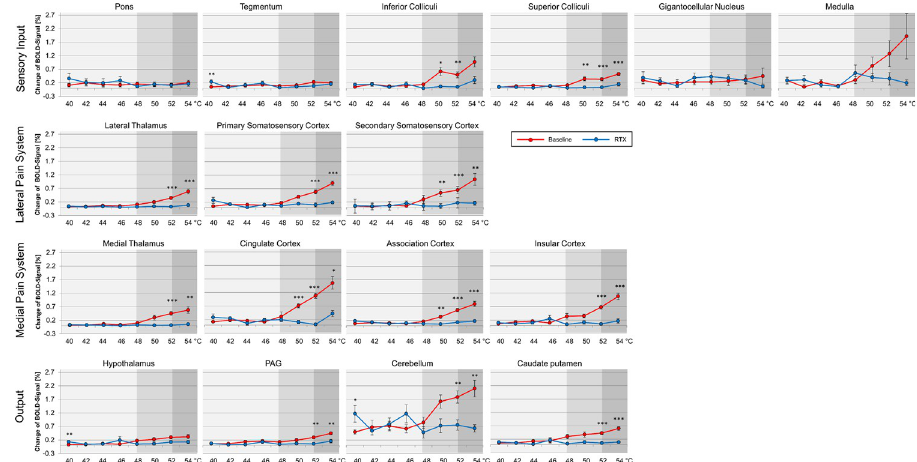
Fig 4. Mean BOLD response amplitudes for representative functional groups. Desensitization of TRPV1-expressing neurons (RTX) had a widespread effect on both sensory-discriminative and emotional-affective brain regions, as well as on some output structures. No or only minor differences between groups were found for brain structures not involved in stimulus-driven tasks, such as the pons, the tegmentum and the output structure hypothalamus, which instead showed significant differences for the activated brain volume, indicating that many voxels were activated at baseline, but with low amplitude (S2 Fig). Statistical significance between groups was calculated using homoscedastic Student’s t-test and corrected for multiple comparisons by FDR q = 0.05. Data are represented as mean ± standard error (SEM). � p � 0.05; �� p � 0.01; ��� p � 0.001. (n Baseline = 18; n RTX = 9).